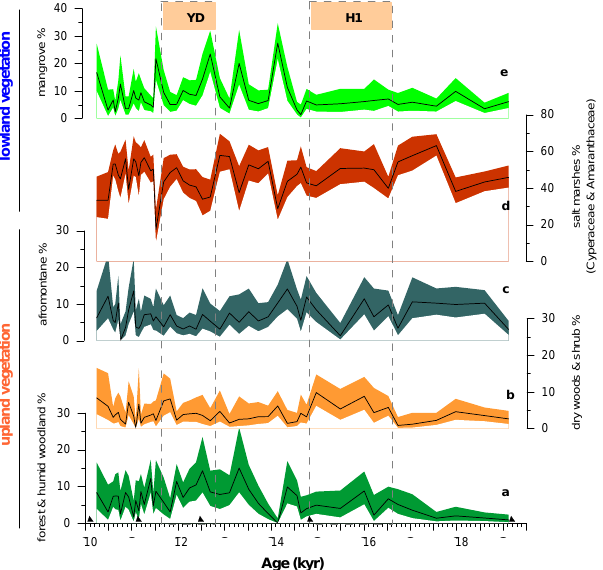
Figure 7. Palynological data showing relative abundances of major pollen groups based on the total sum of pollen and spores. (a) Pollen percentages of forest and humid woodlands, (b) pollen percentages of dry woods and shrubs, (c) Afromontane taxa pollen percentages, (d) percentages of salt marshes (Cyperaceae and Amaranthaceae), (e) mangrove-pollen percentages. Shadings indicate the 95% confi- dence interval. Dashed lines denote time intervals of Heinrich event 1 (H1) and the Younger Dryas (YD). Triangles indicate age control points.